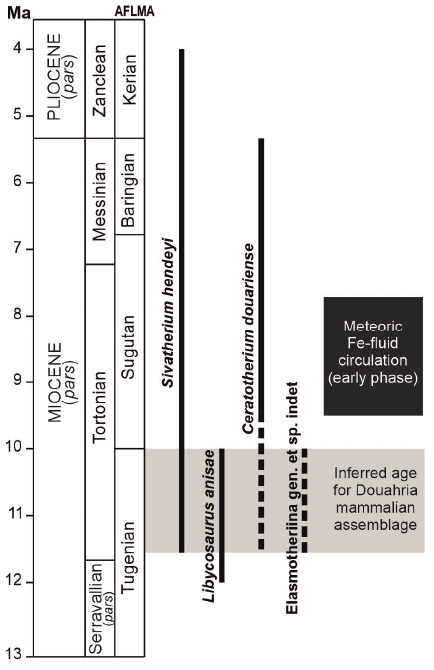
Figure 7. Biochronological chart of late Neogene times, detailing the inferred ages of both the Douahria mammalian assemblage and first phase of meteoric fluid circulation. Biochronological data from [19,20,61,62]. AFLMA = African Land Mammal Ages [73].